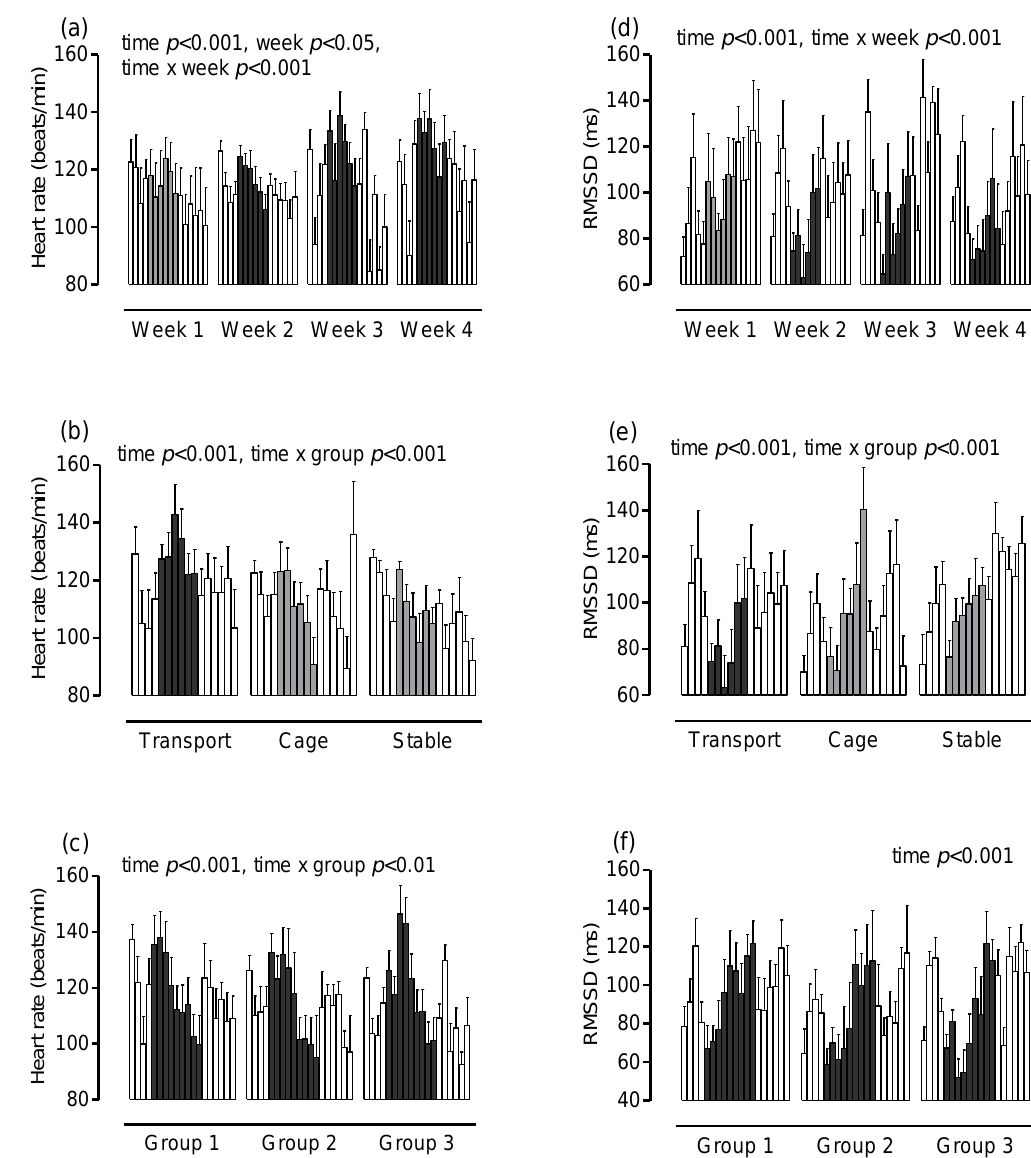
Figure 3. ( a – c ) Heart rate and ( d – f ) root mean square of successive beat-to-beat di ff erences (RMSSD) in ( a , d ) the same dogs ( n = 6) either resting in their stable (week 1) or transported by road for one hour at one week intervals (weeks 2–4); ( b , e ) three groups of dogs ( n = 6 each) either transported by road for one hour, placed in the transport cage in a stationary car or remaining in their stable and ( c , f ) the same three groups of dogs transported by road for two hours, white bars = pre and post-transport or control phase time, black bars = transport time and grey bars = respective control time, values are means ± SEM, significant di ff erences are indicated in the figures.